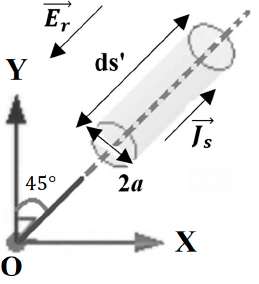
Figure 2. Linearly polarized wave incident to an elementary dipole. By applying the boundary conditions, the superficial current density induced on the surface of the radiator will be: